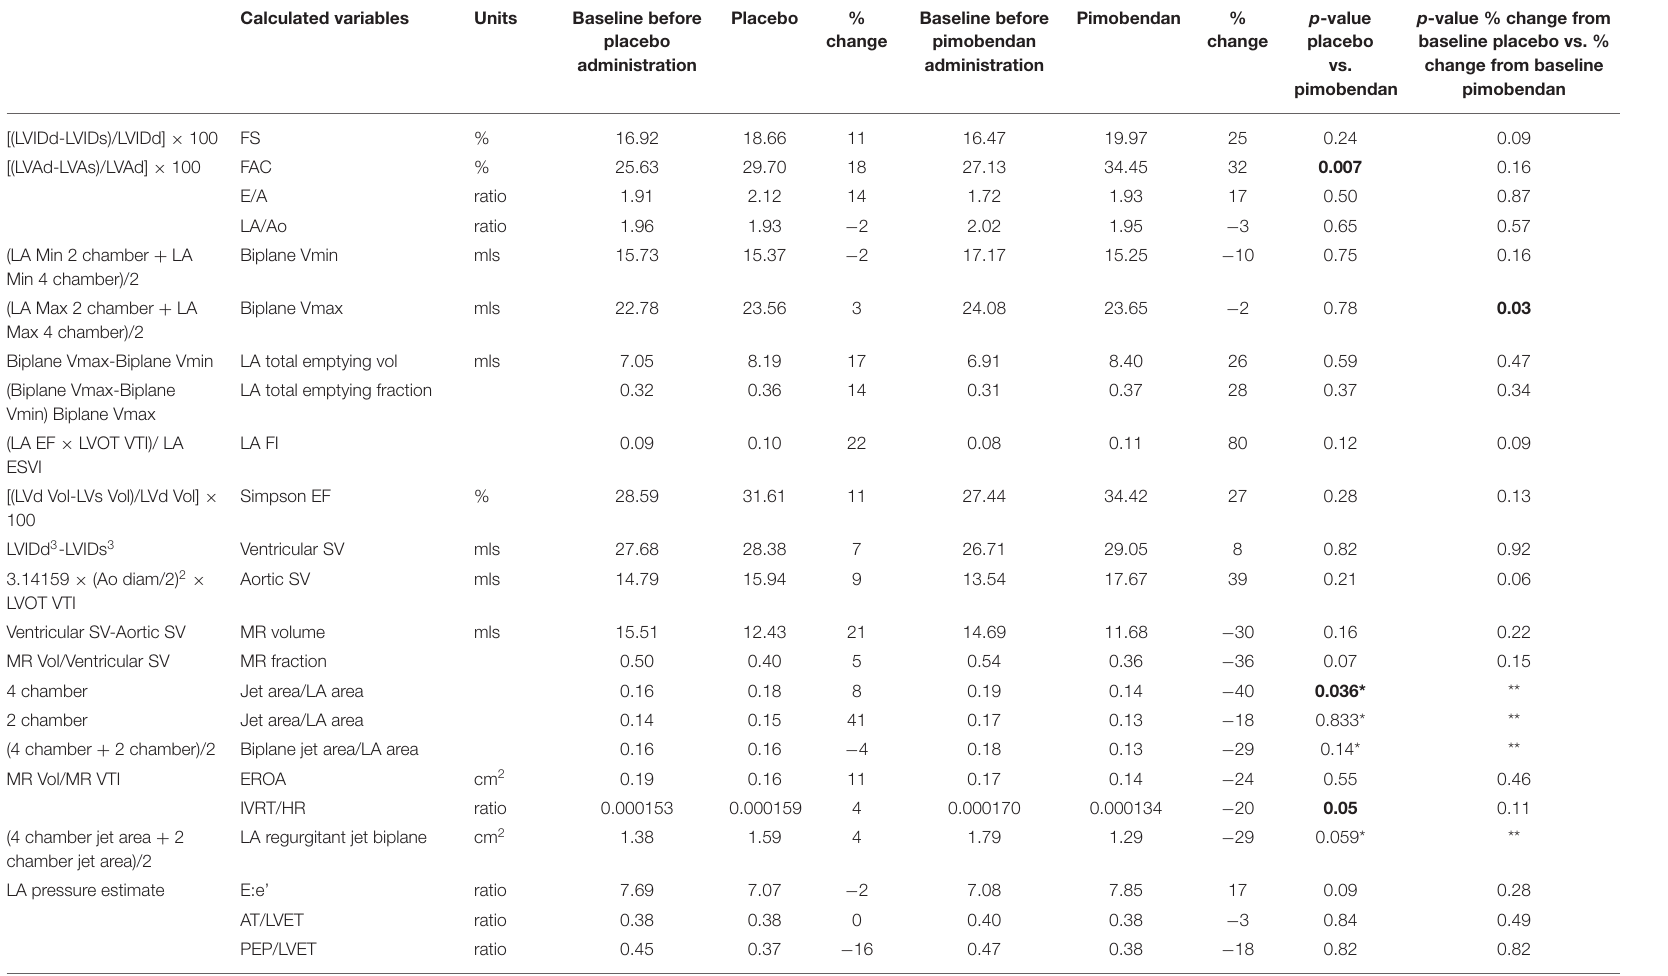
TABLE 2 | Calculated results from echocardiographic data. Calculated variables Units Baseline before